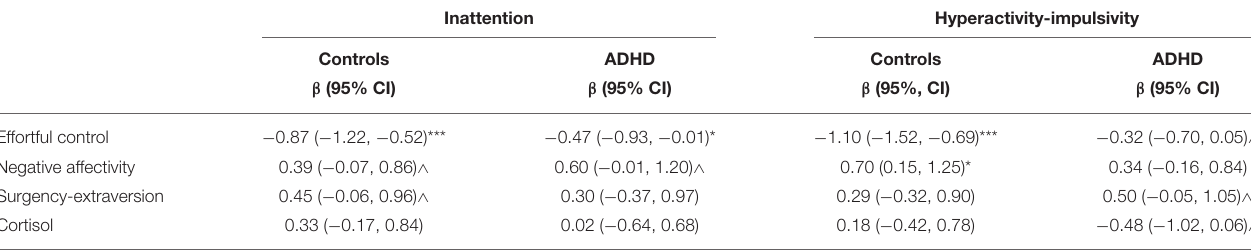
TABLE 2 | Association of each subdomain of the ADHD traits with the three temperament dimensions and awakening cortisol